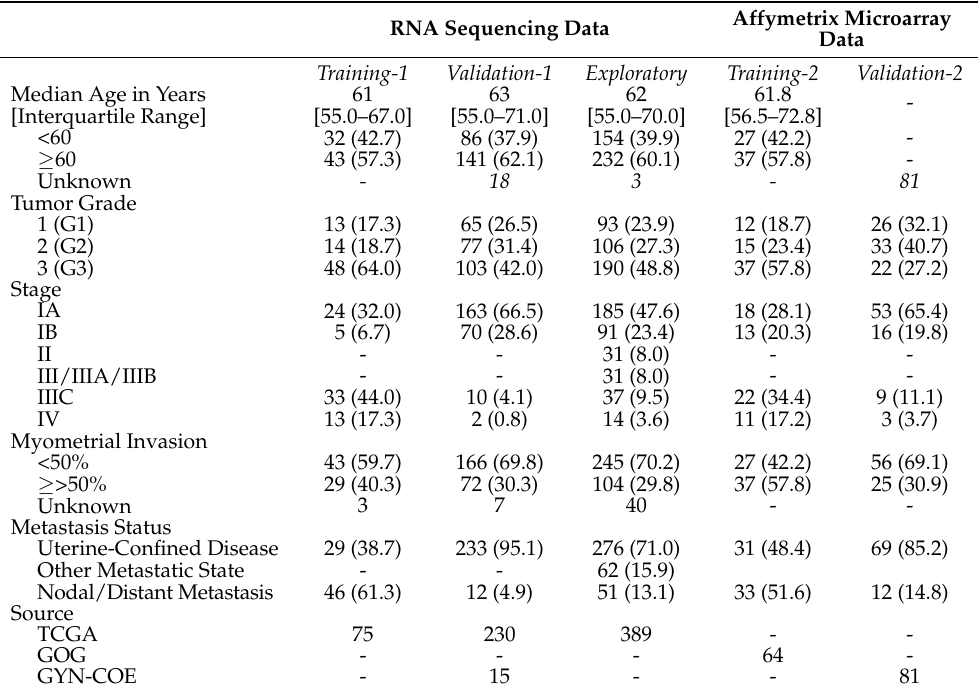
Table 1. Clinical characteristics by source for the endometrioid endometrial cancer (EEC) patients with stage I, IIIC or IV disease and RNA sequencing data or Affymetrix Plus 2.0 microarray data in the primary analysis or with stage I–IV disease and RNA sequencing data for the exploratory